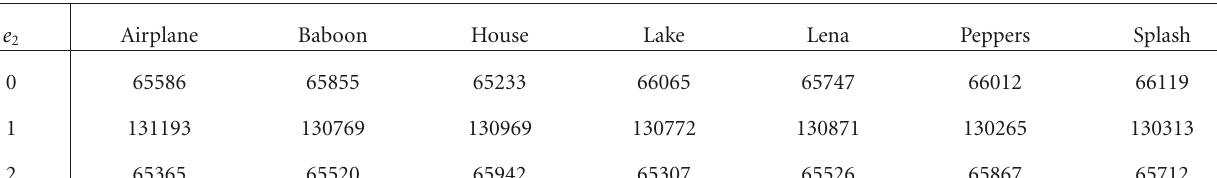
Table 2: Residue distributions of Bayer data with rounding operation. These Bayer CFA data are generated from seven standard test color images with size 512 × 512